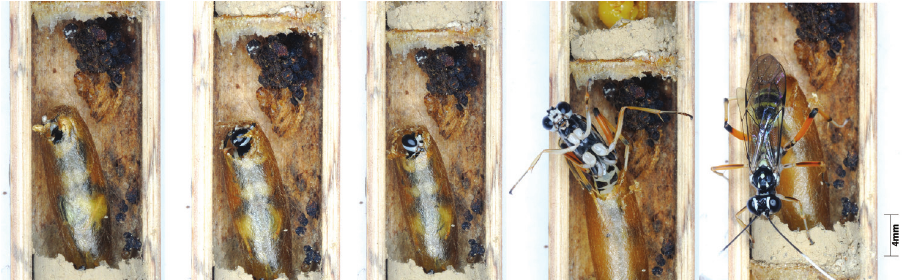
Figure 5. The emergence sequence of an adult Hadrocryptus perforator from trap